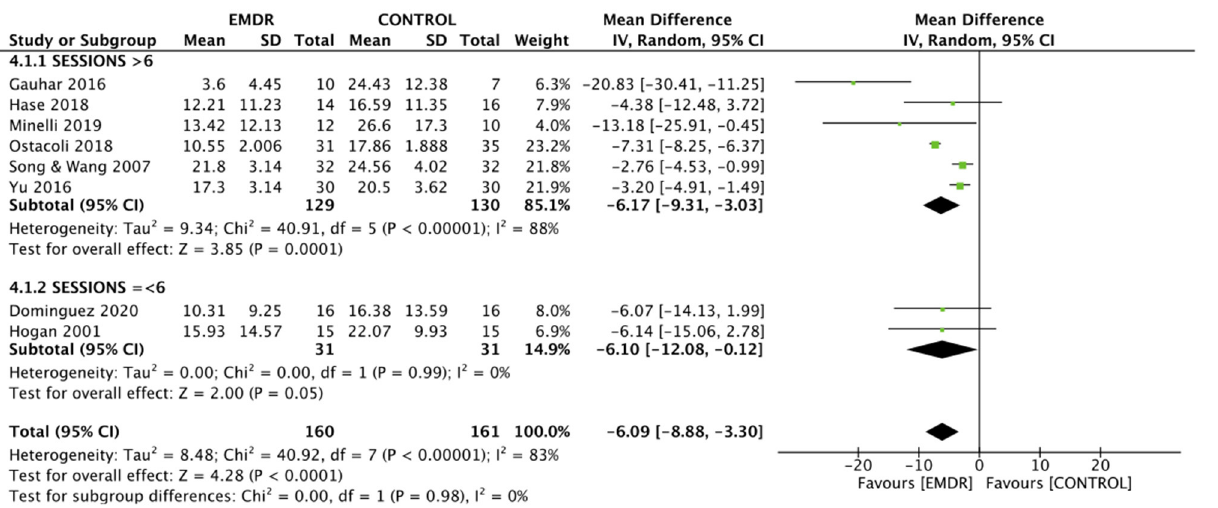
FIGURE 8 | Effect of EMDR between sessions ≤ 6 and sessions > 6 on severity of MDD. EMDR, eye movement desensitization and reprocessing; MDD, major depressive disorder.